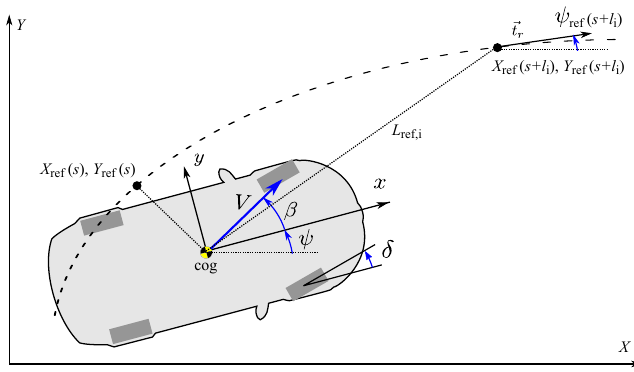
Figure 5. Model of the close-loop driver as a path follower